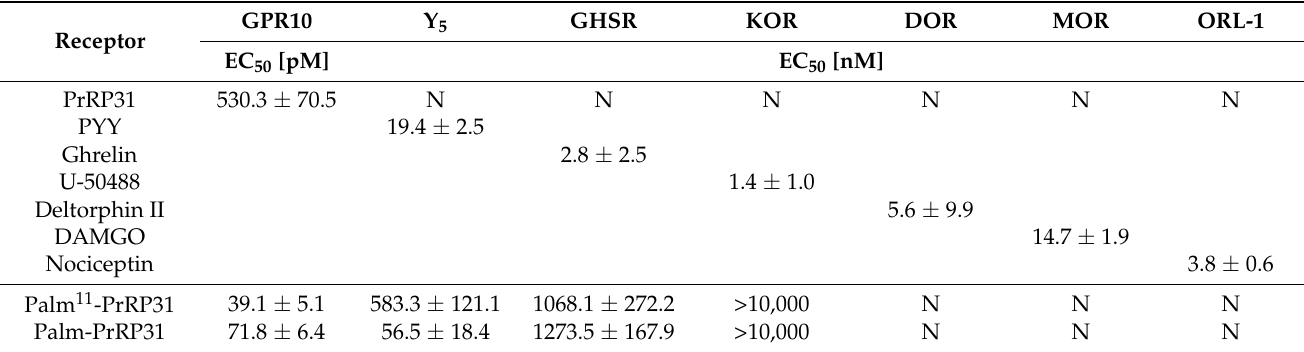
Table 4. Agonist properties on GPR10 and other potential off-target receptors determined using β -lactamase assay. GPR10 Y 5 GHSR KOR DOR MOR ORL-1 Receptor EC 50 [pM] EC 50 [nM] PrRP31 530.3 ±